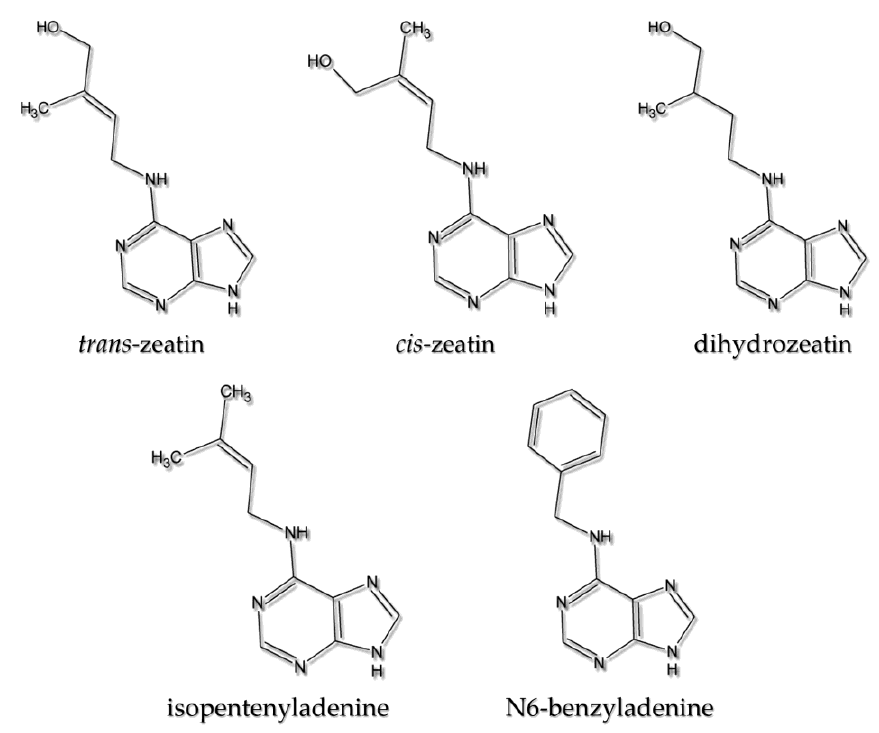
Figure 1. Structures of example purine cytokinins.